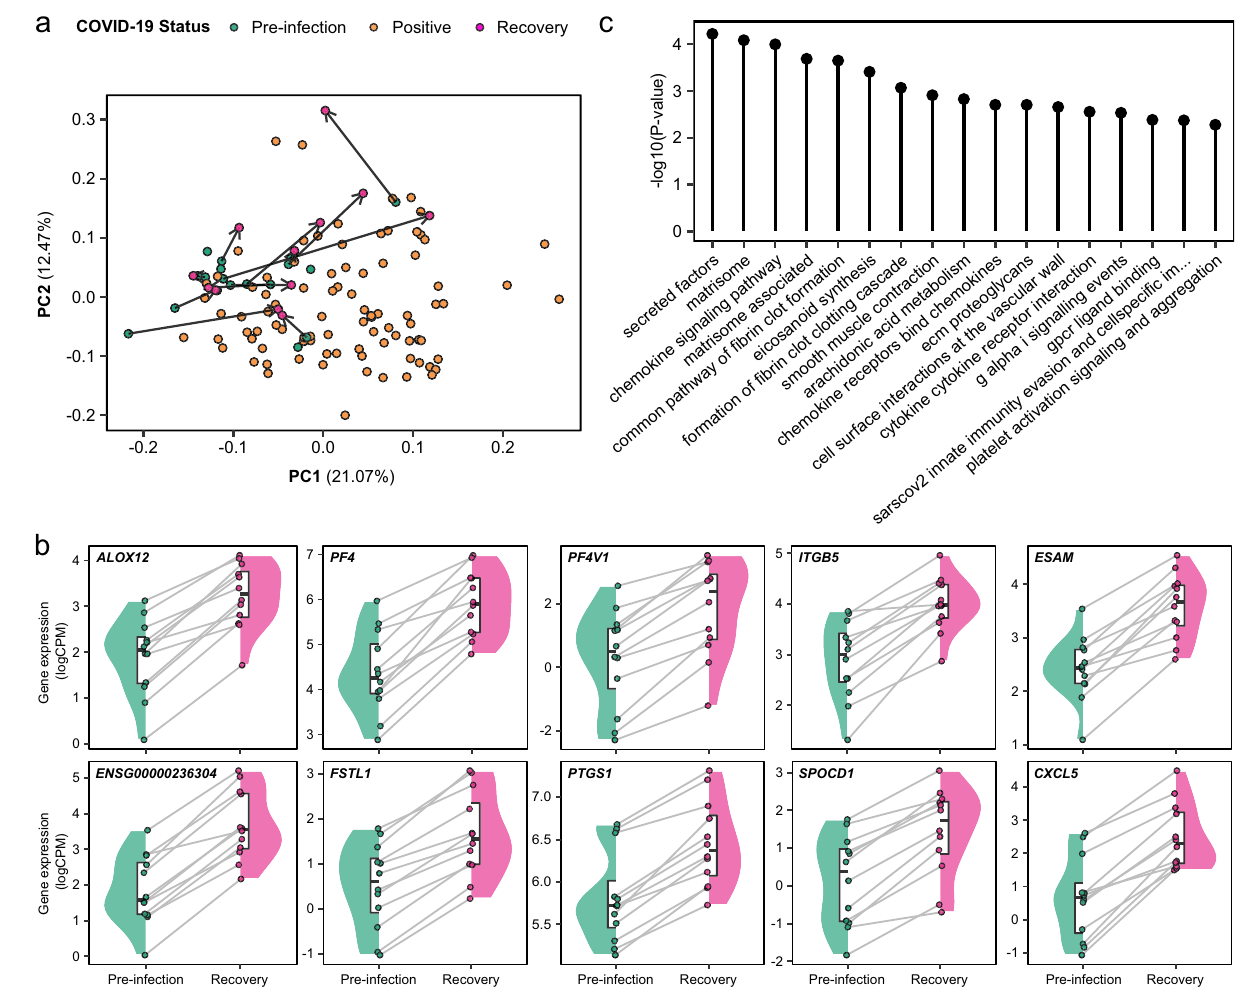
Fig. 7 | Persistent dysregulation of immune cell gene expression two months following COVID-19. a PCA of the Wave 2 PBMC transcriptomic data, including pre-infection, infection and recovery samples (taken 2 months after the acute ill- ness). Each point represents a sample. Arrows link recovery samples to the pre- infection sample from the same individual. b Paired violin plots for differentially expressed genes in recovery versus pre-infection samples ( n =24 samples from 12 individuals).Greylineslinkeachindividual ’ spre-infectionsampletotheirrecovery